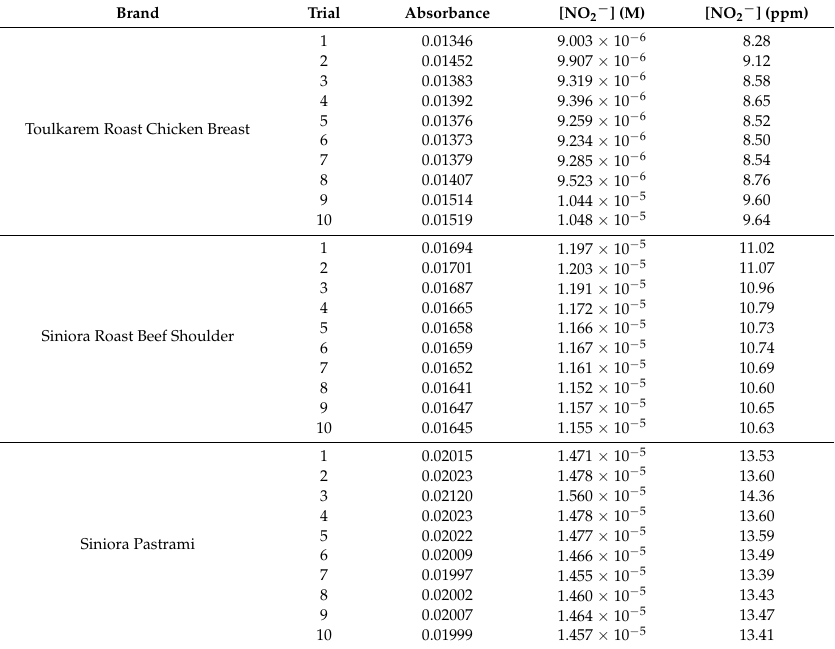
Table A1. The absorbance and the nitirite concentration in the tested meat